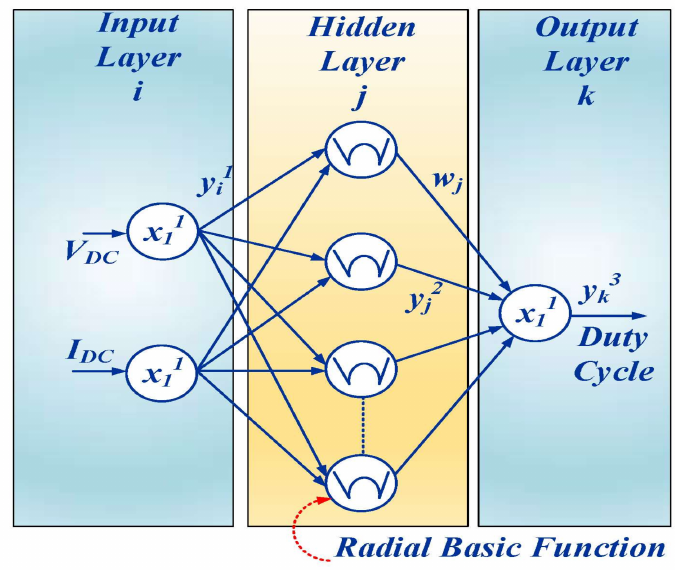
Figure 5. Radial basis function network